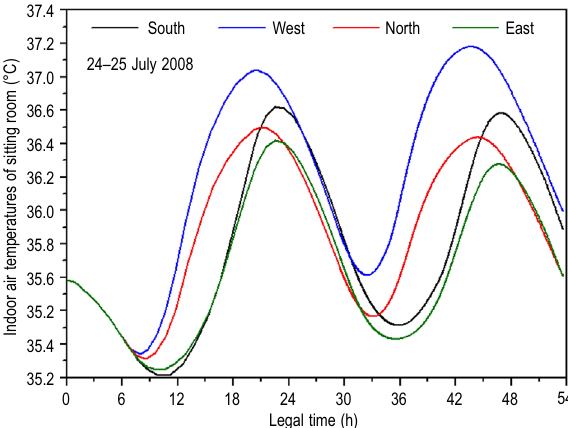
Fig. 7. Sitting room temperatures, S/V ratio = 0.5882, July 24 and 25, 2008